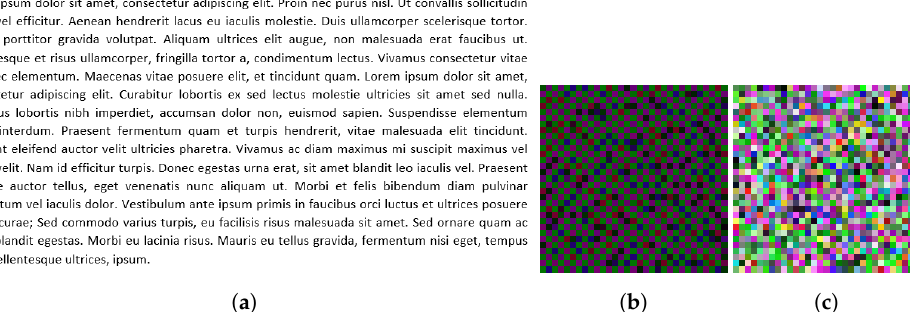
Figure 4. Test File 1 text message, transformed message into a png image and its cipher-image. ( a ) Lorem Ipsum text. ( b ) Text message in image form. ( c ) Encrypted